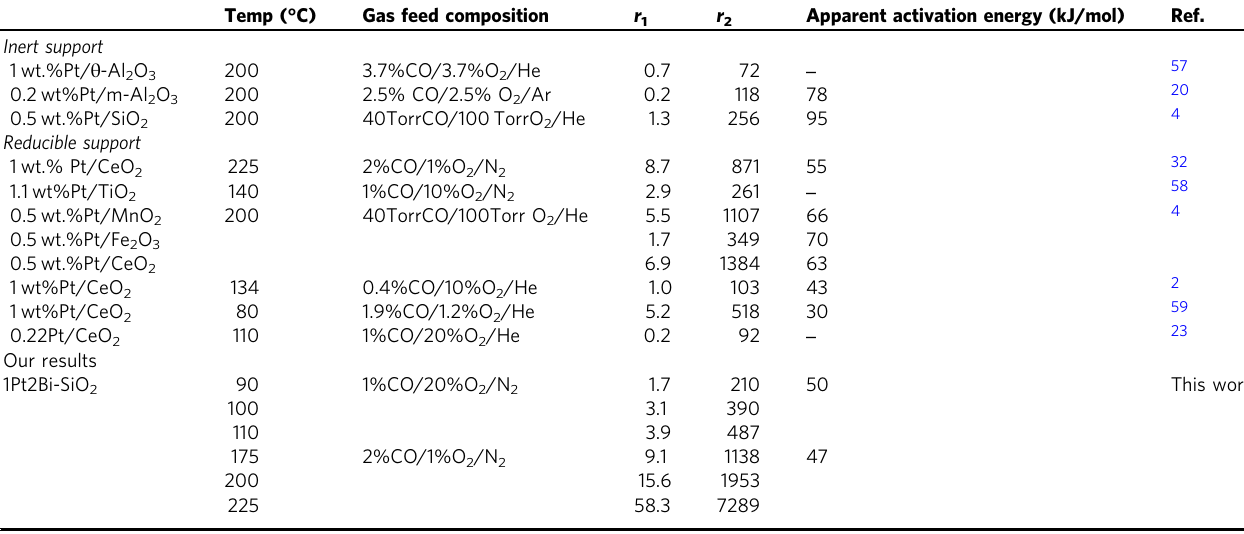
Table 1 Comparison of the activities over the representative platinum catalysts for the oxidation of carbon